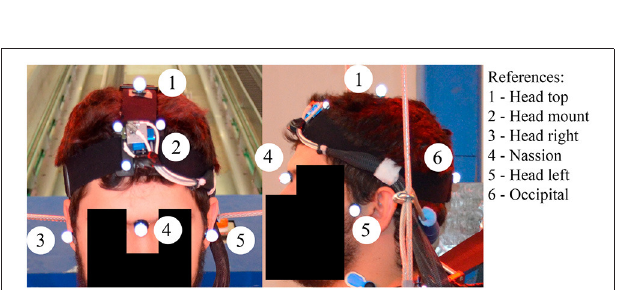
the head breadth, depth, and circumference, was also used.